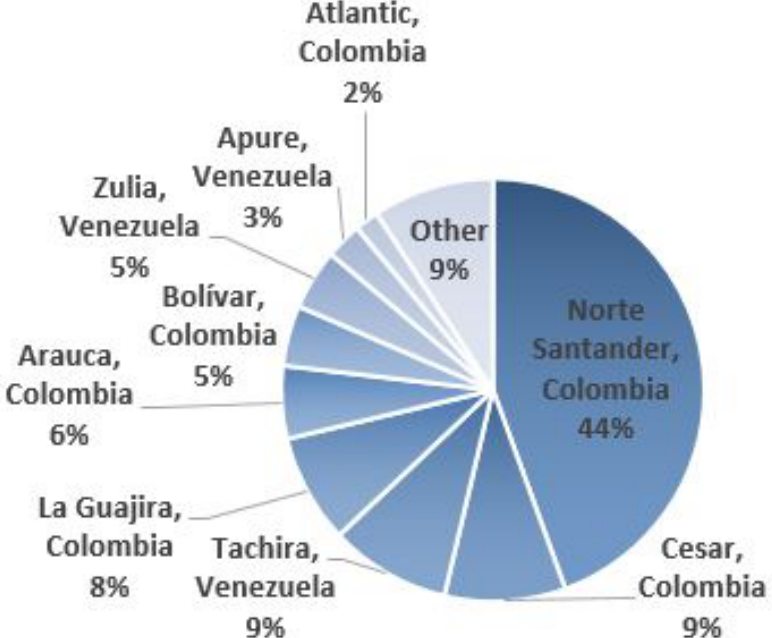
Figure 3. VNSAs into strategic departments. Elaborated by the authors, based on data from selected newspaper articles from the region [38–74].